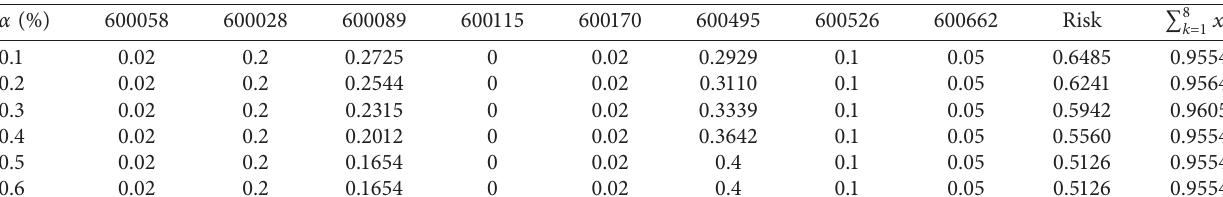
0 . � 0 . 2 ( % ) and μ � 8 ( % ) . 0